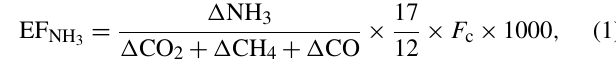
Figure 2. Time traces of (a) mixing ratios of NH 3 , NH during a transect of the Williams Flats Fire plume on 7 August